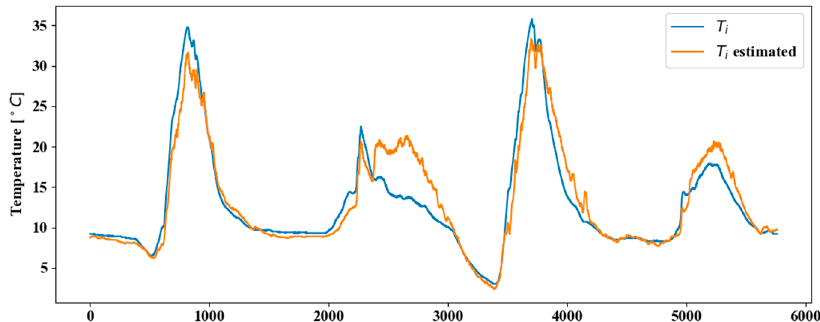
Figure 29. Recorded dataset ( T i , H i -indoor air temperature/ relative humidity, T ext -outdoor air temperature) [66].